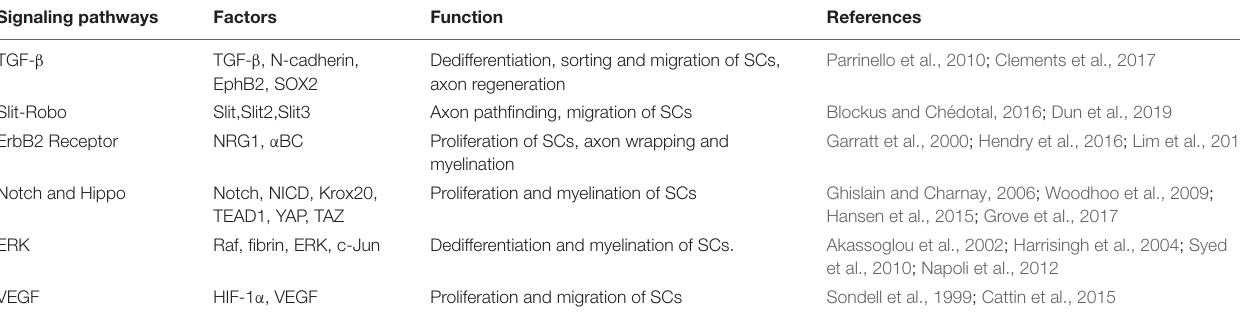
TABLE 1 | Key signaling pathways involved in migration, proliferation and axon guidance of SCs after PNI. Signaling